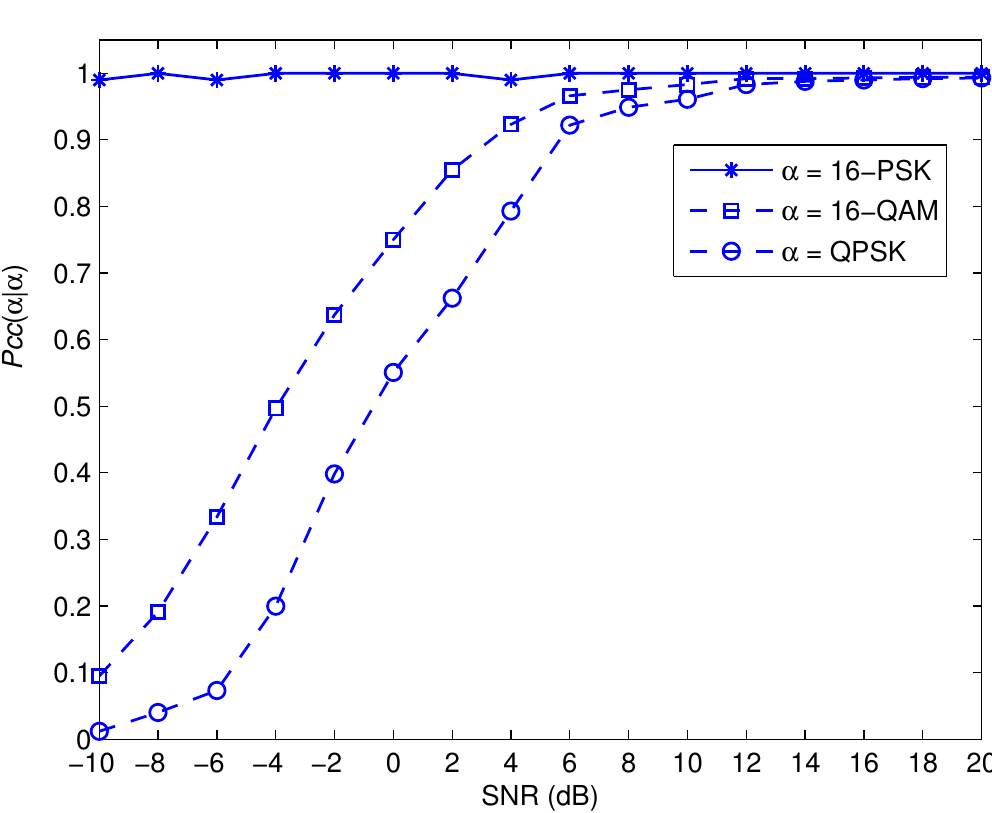
Figure 9. Pcc ( α | α ) for the modulation group of θ 3